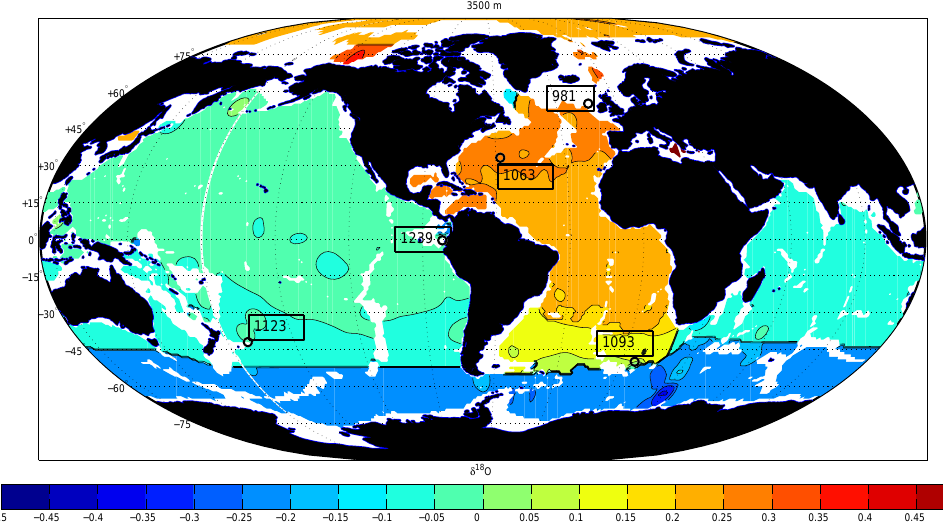
Figure 2. Modern δ 18 O w at 3500m (from LeGrande and Schmidt, 2006) with superimposed core positions (black circles). Note, however, that the core tops are not generally at this depth (Table 2). G. Gebbie (personal communication, 2015) concluded that the structures in this chart are overly sensitive to the method used for gridding. Region of little or no data in the Southern Ocean is bounded by the thick black